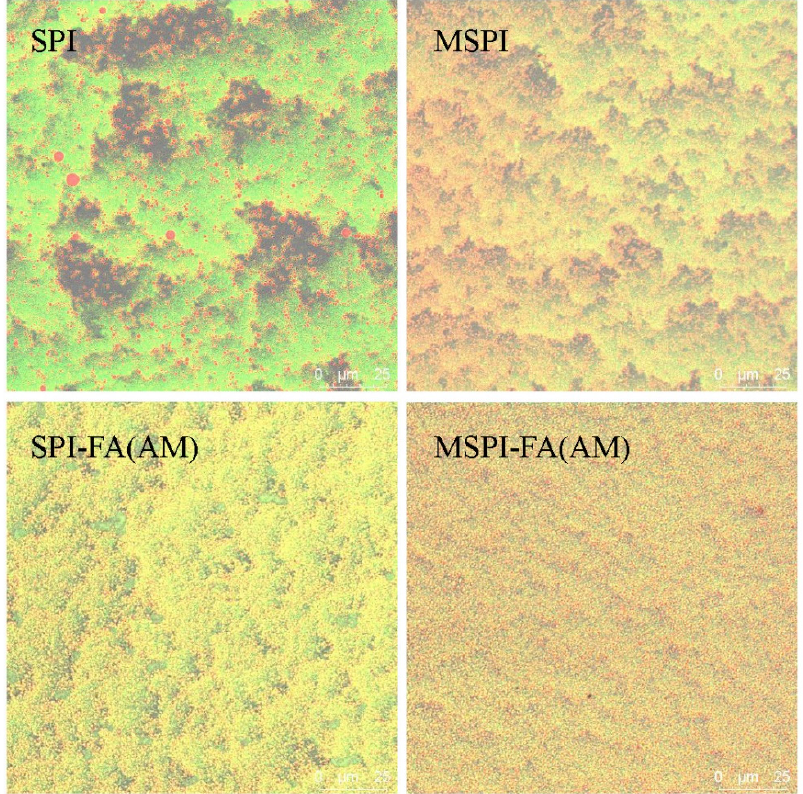
Figure 5. CLSM microscopy of emulsion gels induced by different modified soybean protein iso- lates.